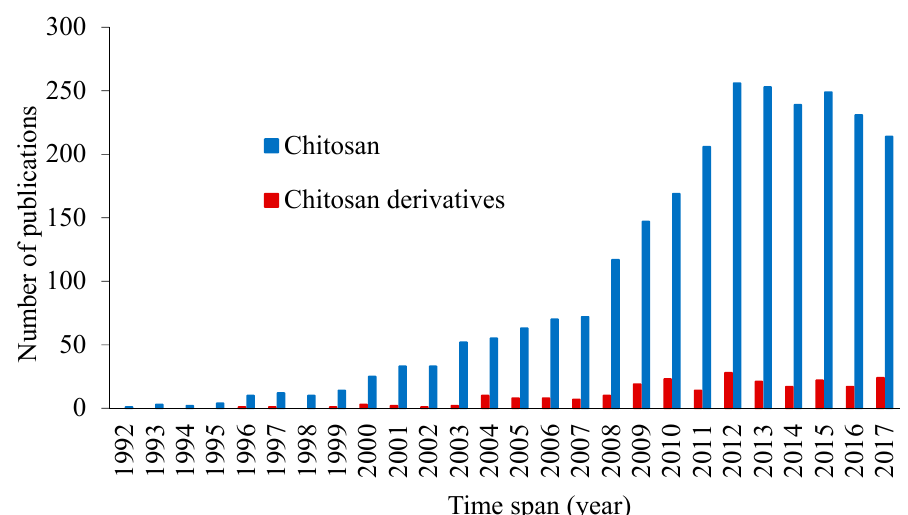
Figure 2. Number of publications related to mucoadhesive properties of chitosan and chitosan derivatives, source: SciFinder, keywords: chitosan or chitosan derivatives and mucoadhesion, retrieved on 24 November 2017.